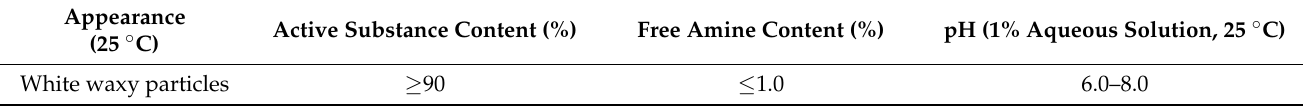
Table 2. Physicalindex of stearyl trimethyl ammonium chloride.